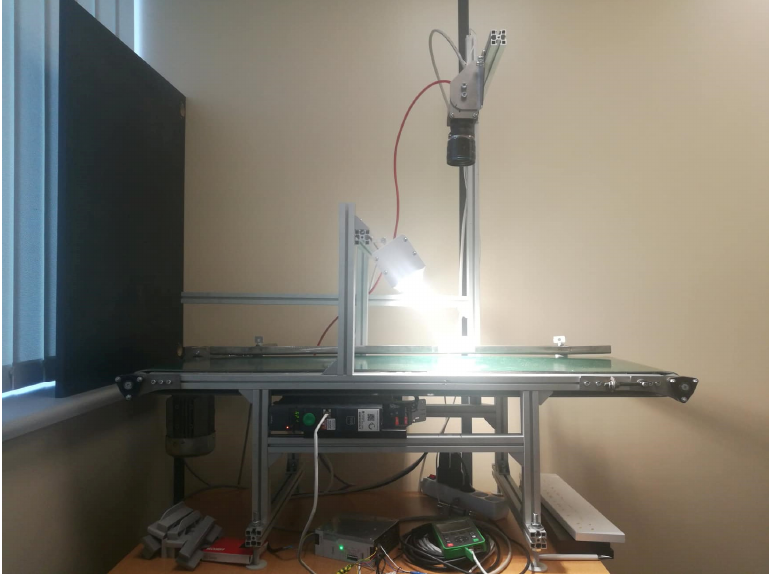
Figure 1. Conveyor belt developed for wood surface quality evaluation.